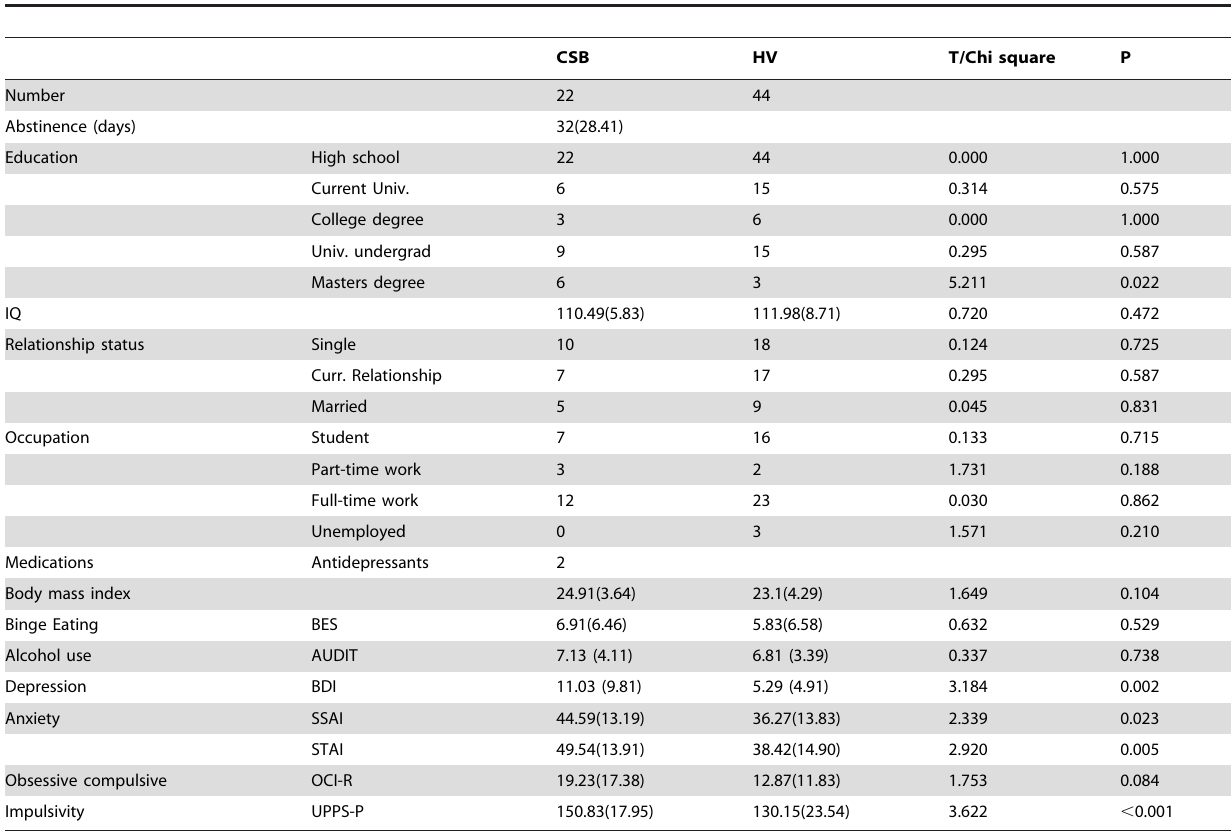
Table 1. Subject